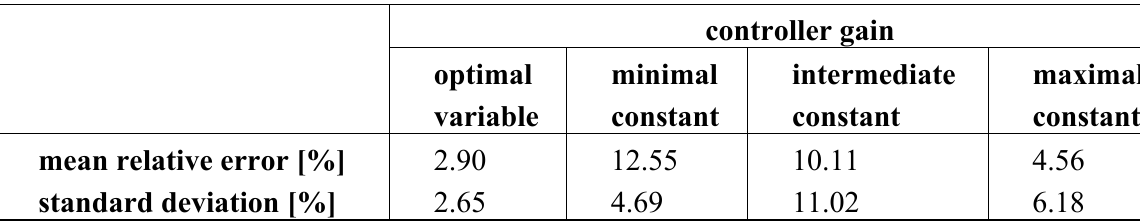
Table 3 . Distribution parameters including relative